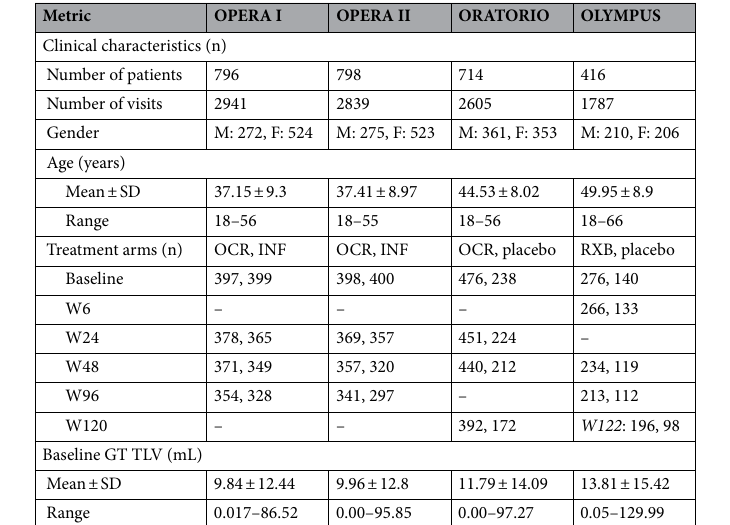
Table 1. Summary of clinical and GT lesion characteristics of OCR and RXB clinical trial datasets in patients with MS. GT ground truth, INF interferon, OCR ocrelizumab, RXB rituximab, SD standard deviation, TLV total lesion volume, W